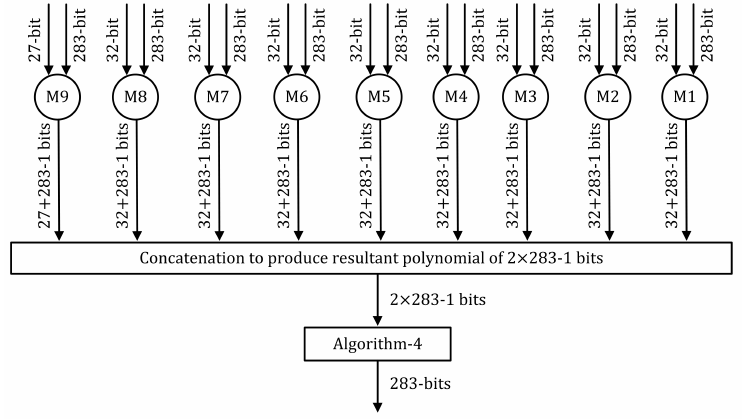
Figure 4. Digit-parallel multiplier over GF ( 2 283 )